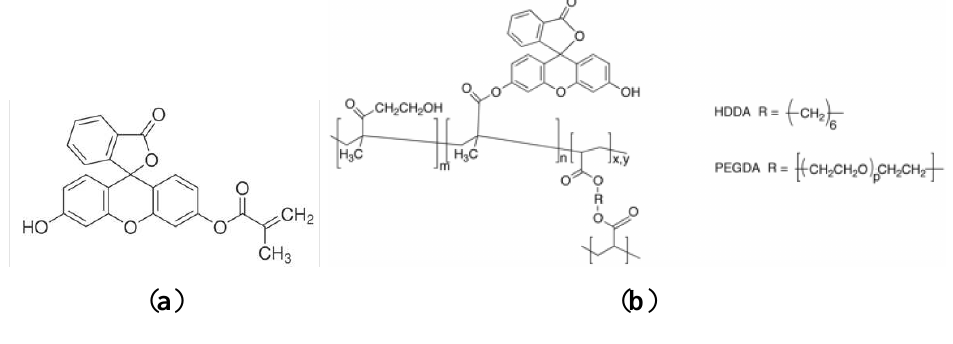
Figure 2. ( a ) Molecular structure of Fluorescein O -methacrylate. ( b ) Molecular structure of poly(HEMA) covalently bonded to Fluorescein O -methacrylate units.